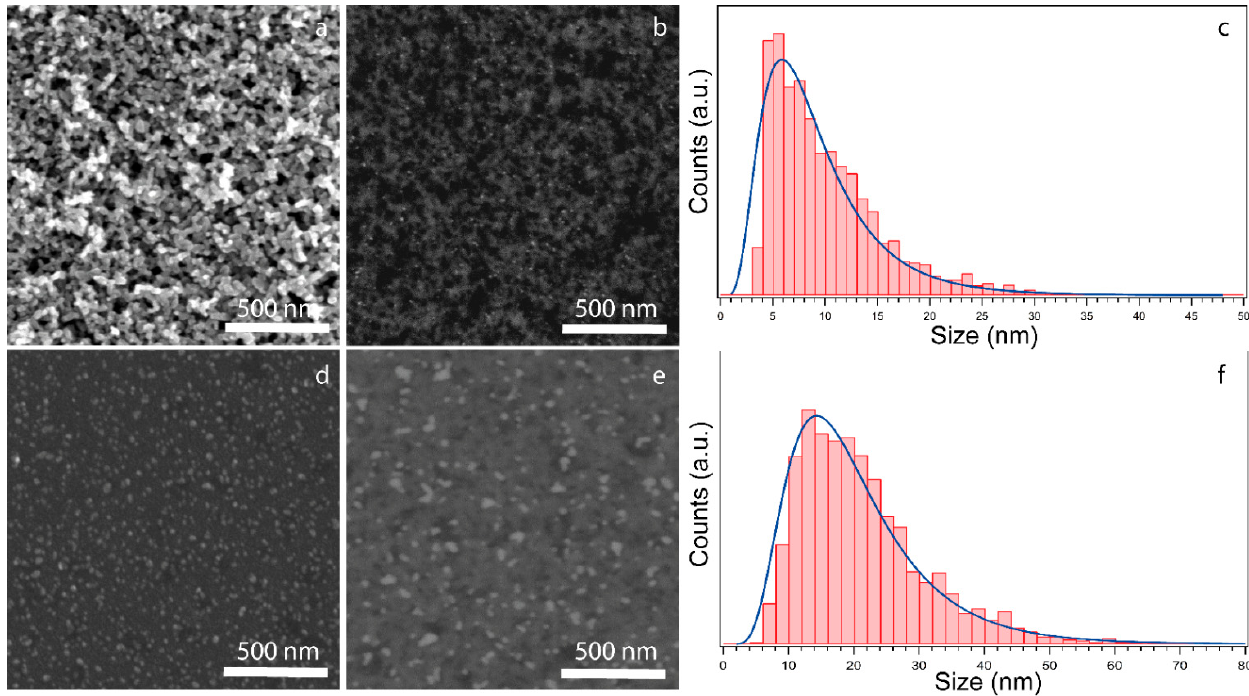
Figure 3. ( a ) SE SEM image of a typical mesoporous TiO 2 sample, ( b ) BSE SEM image of 1.5% coverage in Ag/MgO sample on m ‐ TiO 2 , ( c ) size distribution resulting from analysis of Figure 3b corresponding to 1.5% NP coverage, ( d ) SE SEM image of Ag/MgO NPs with 10% coverage on a flat TiO 2 substrate, ( e ) BSE SEM image of 10% coverage of Ag/MgO NPs on m ‐ TiO 2 , ( f ) size distribution resulting from analysis of Figure 3d.